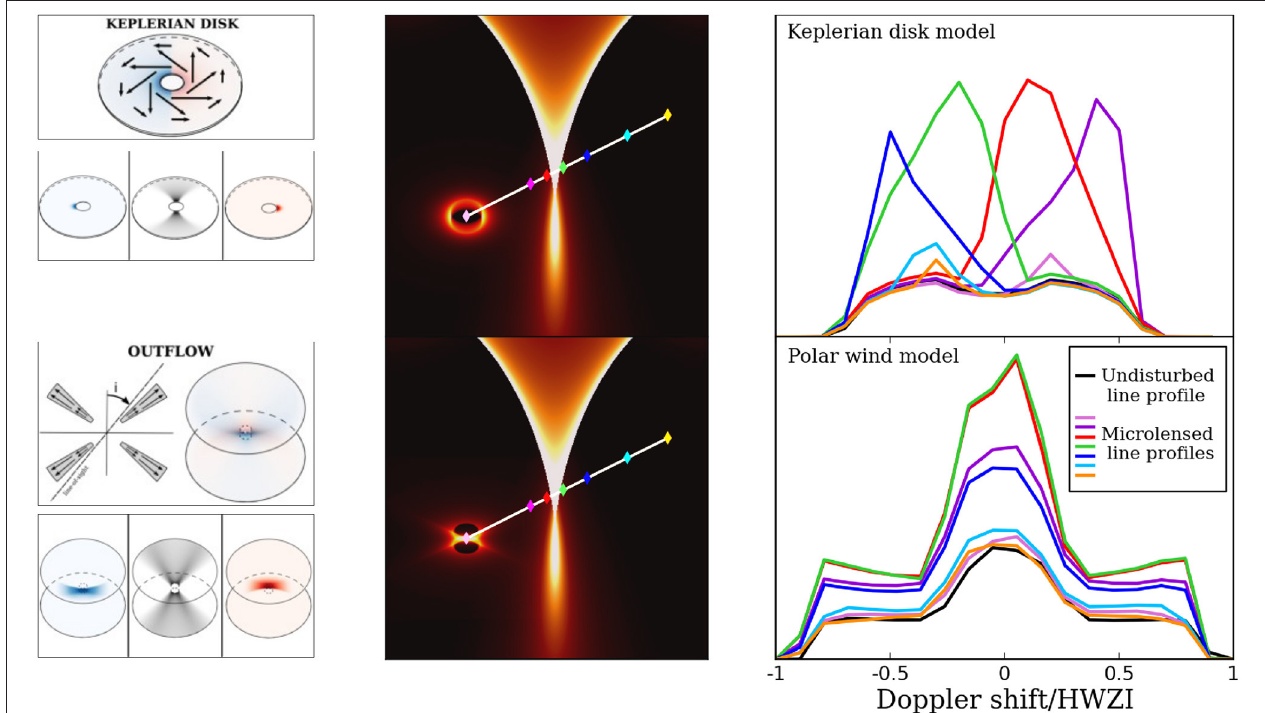
FIGURE 3 | Microlensing of different BELR structures and the resulting line profile distortions. The left panel sketches two models: a rotating Keplerian disk and a biconical outflow, both seen at intermediate inclination. The location of the approaching and receding gas is indicated in blue and red, respectively. The middle panel shows the BELR superimposed on a typical caustic. At the different positions indicated by colored losanges, different subregions of the BELR are magnified by the caustic. The right panel illustrates the line profiles corresponding to the different positions of the BELR onto the caustic pattern. Microlensing of the Keplerian disk is characterized by asymmetric red/blue line profile distortions while microlensing of the biconical outflow is characterized by symmetric wings/core distortions.